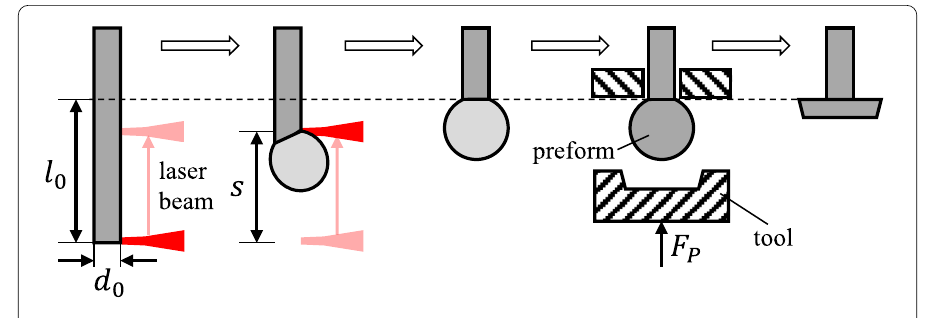
Figure 1 Two-level cold forming process: In the master forming step, a preform is generated by melting the end of the wire (thermal upsetting) that is calibrated in a subsequent cold forming step